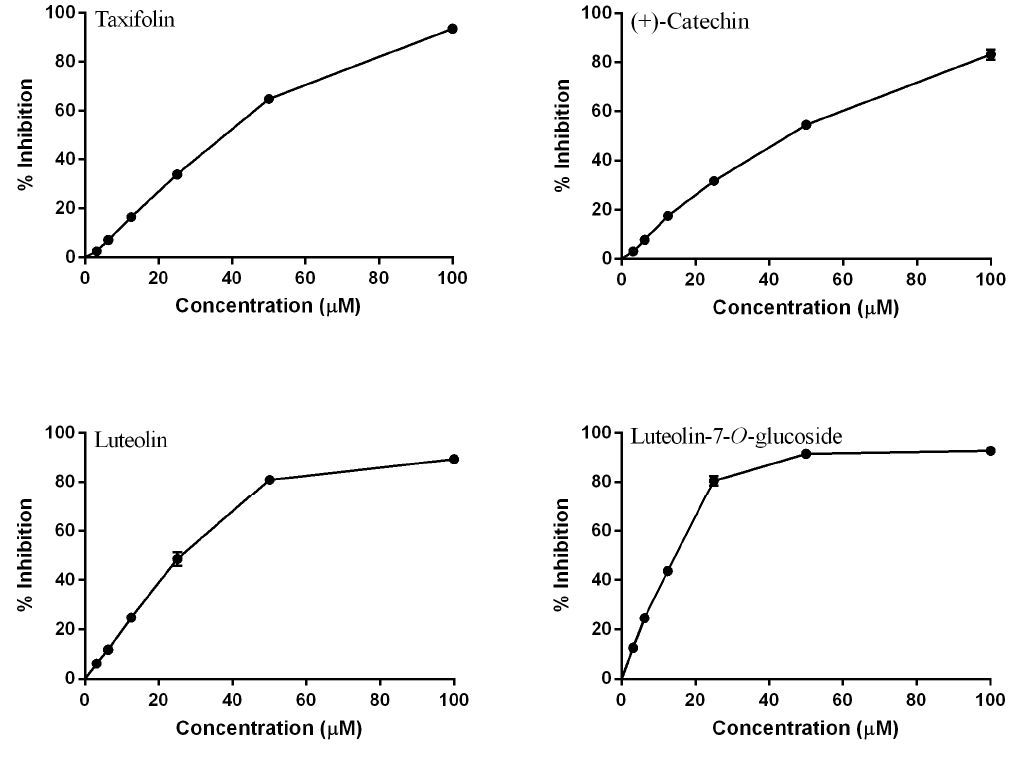
Figure 2. Dose-response curves of tested flavonoids from other classes (mean ± SEM of three